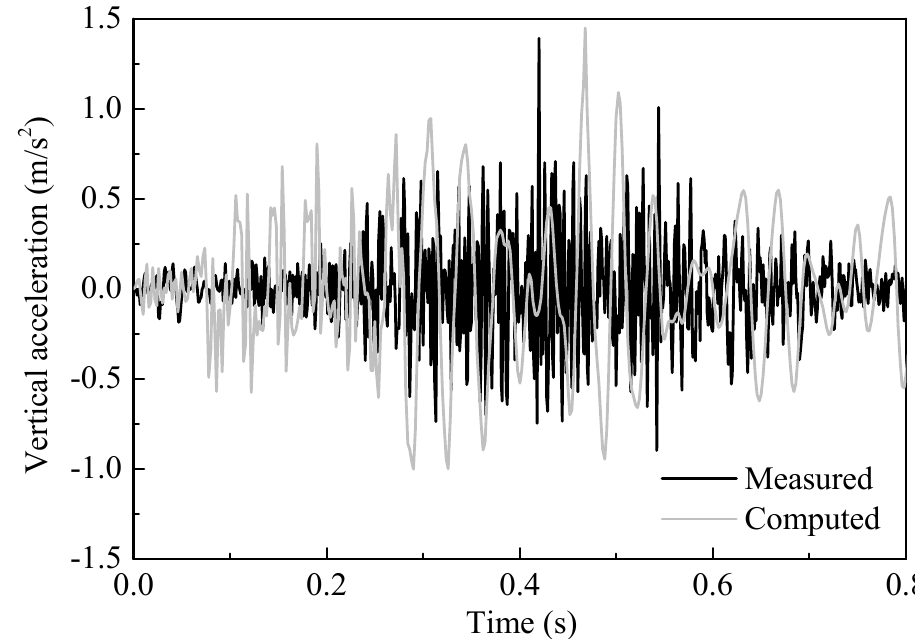
Figure 7. Computed and measured acceleration time histories on the top layer surface.